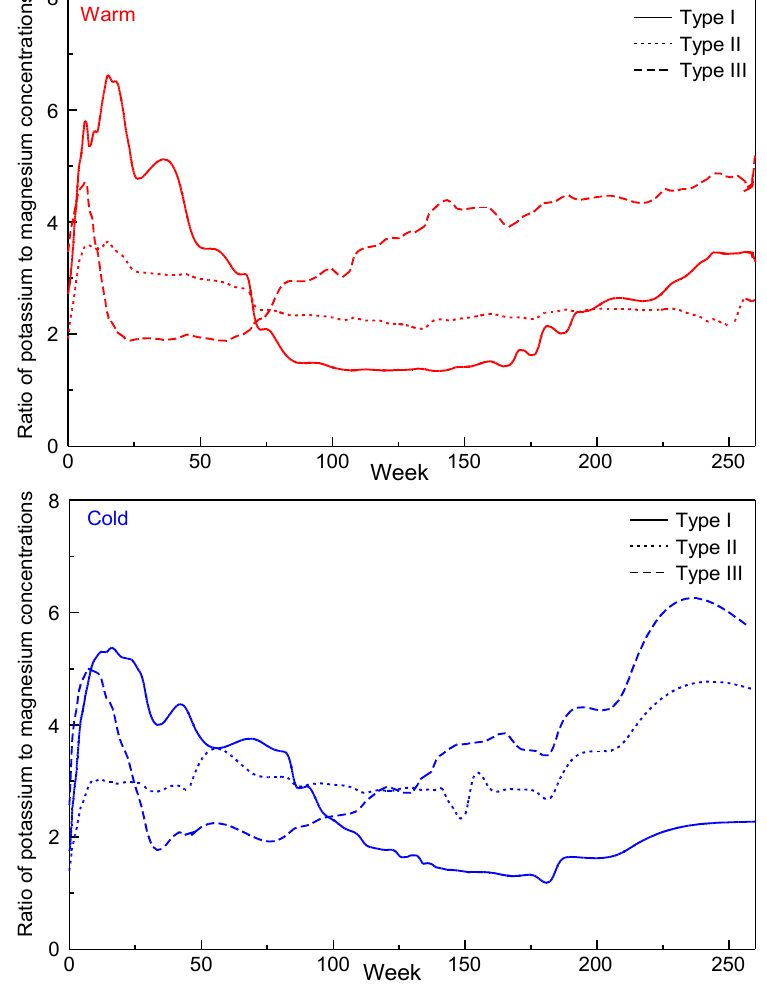
Figure 9. Ratio of K and Mg concentrations (moving average trendline of a 10-data point window) in leachate from warm and cold humidity